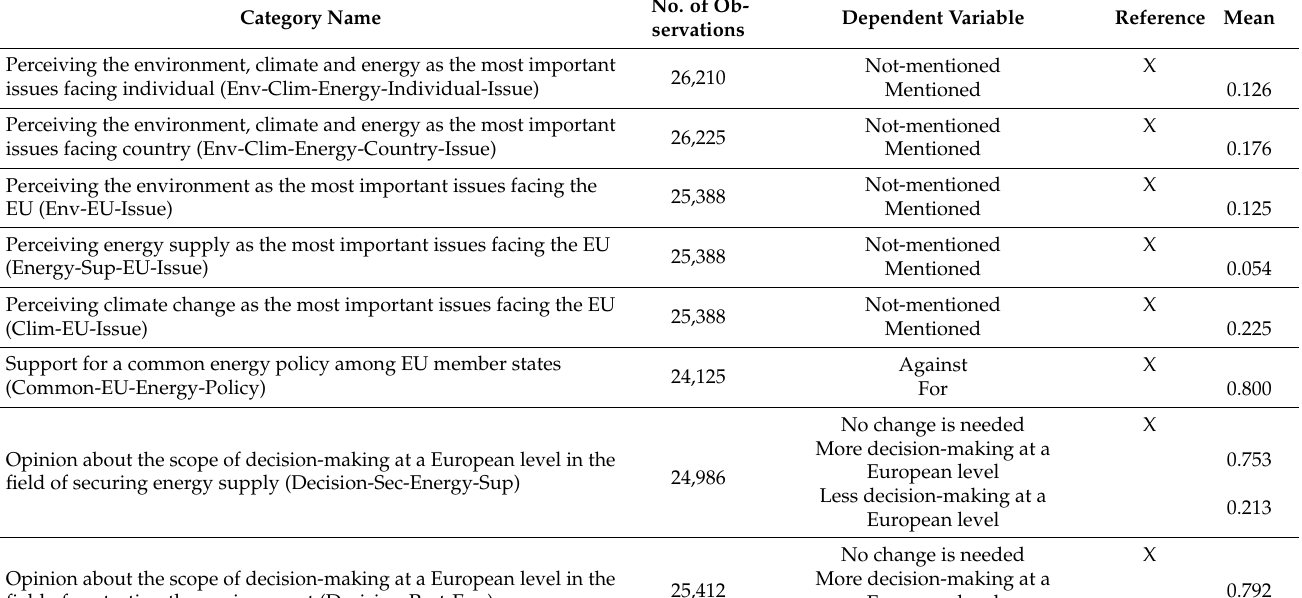
Table 2. Overview of explanatory